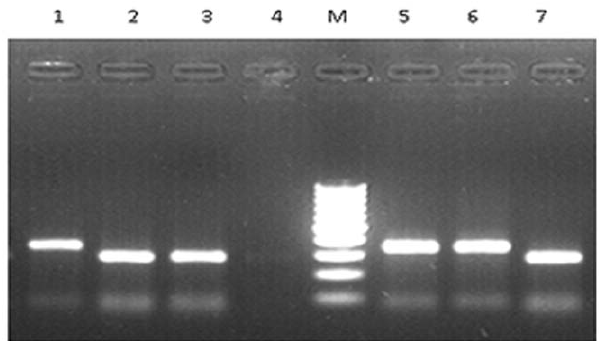
Figure 2. PCR-RFLP analysis of the pncA gene after restriction digestion with Bse LI. The pncA gene was analyzed for a silent mutation in the 65 th codon at the 195th bp. Mutated alleles correspond to lanes 1, 5 and 6 (344 bp product and one minor fragment of 81 bp). Lanes 2, 3 and 7 denote wild type pattern (280 bp product and two minor fragments of 81 and 64 bp sizes) while lane 4 represents a negative control. Lane M corresponds to the profiling of a 100 bp DNA molecular weight